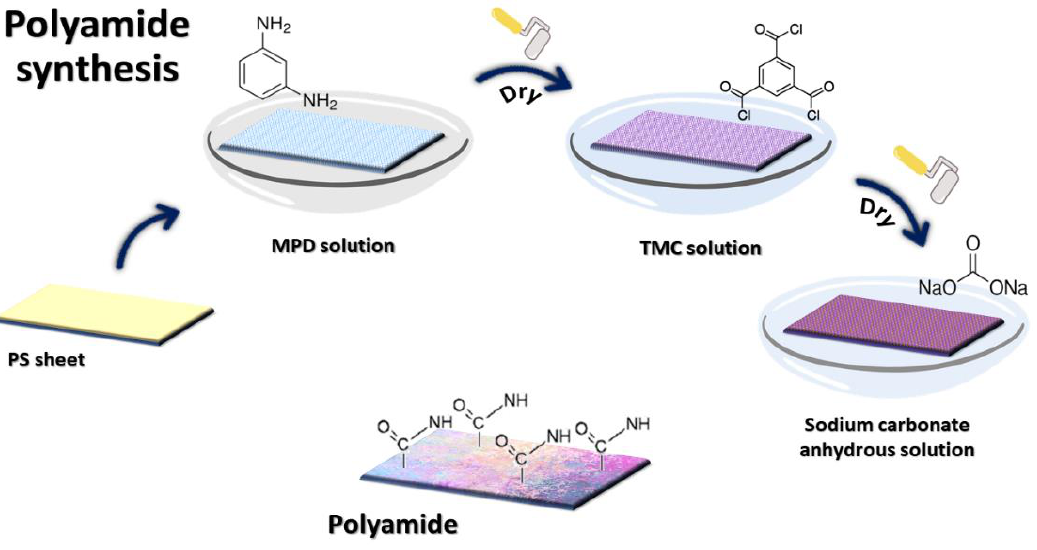
Figure 1. Diagram of PA membrane preparation.